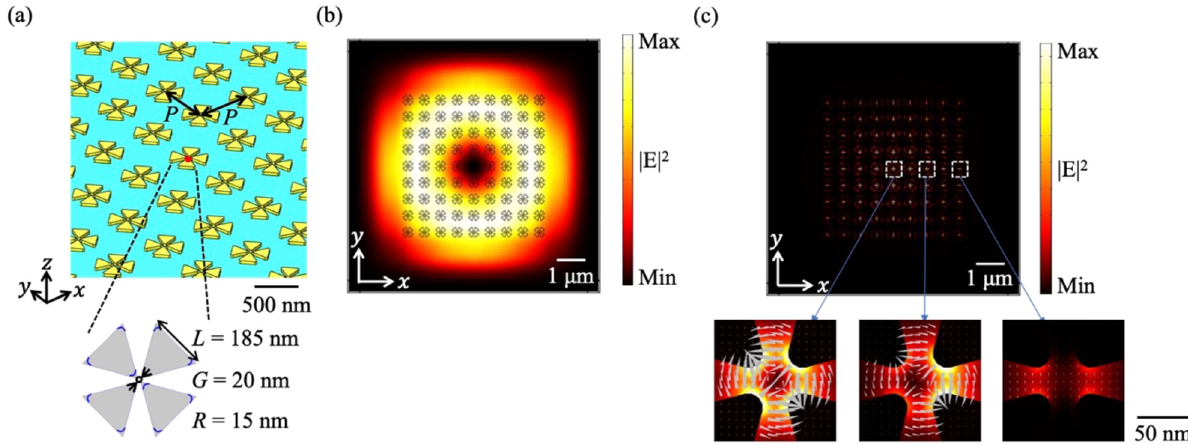
Figure 4: Array of gold tetramers under CV beam illumination. (a) Configurations of the array system. (b) Electric field intensity distribution of the CV beam in the absence of the gold tetramer array. The blackoverlaidtetrameroutlinesindicatethepositionsof thetetramersforthearray with P =560nm. (c)Numerical near- fi eldintensitypro fi le. The lower plots show snapshots of the electric fi eld distributions in which the gray triangles indicate the electric fi eld